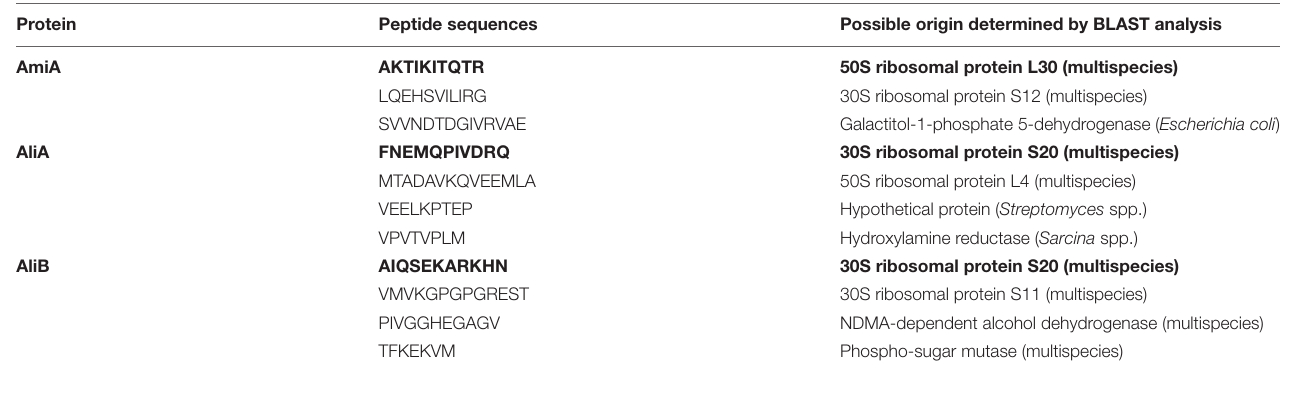
TABLE 1 | AmiA, AliA, and AliB oligopeptide-binding proteins and their putative ligands. Protein Peptide